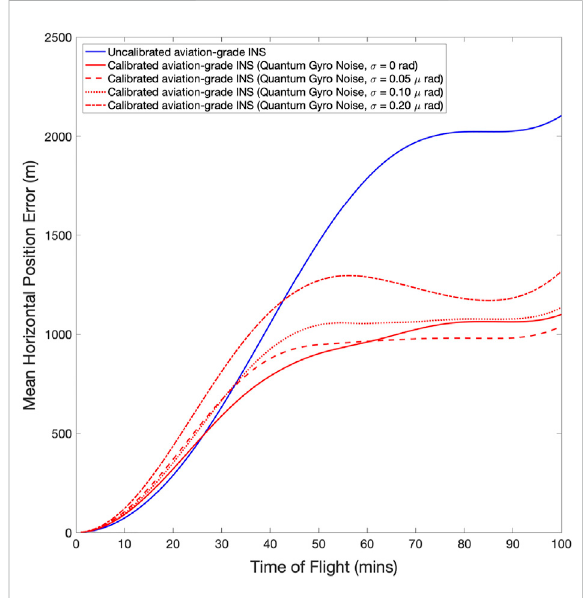
FIGURE 4 Mean horizontal error for an uncalibrated aviation-grade INS solution (blue), an online calibrated aviation-grade INS that is misaligned ( σ =0.005 o ) to perfect cold atom sensors (red, solid), and with gyroscope measurement noise σ =0.05 μ rad (red, dash), σ =0.2 μ rad (red, dotted), and σ =0.2 μ rad (red, dot-dash). The means are calculated over 50 realisations of the errors for the full